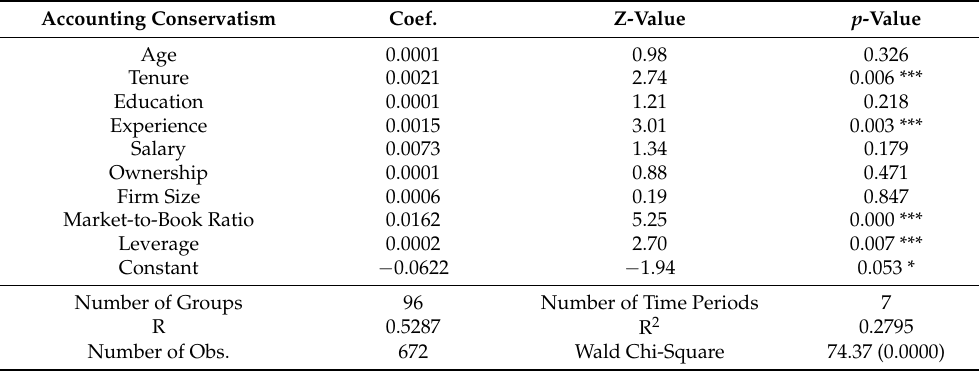
Table 6. Estimation results of the panel FGLS